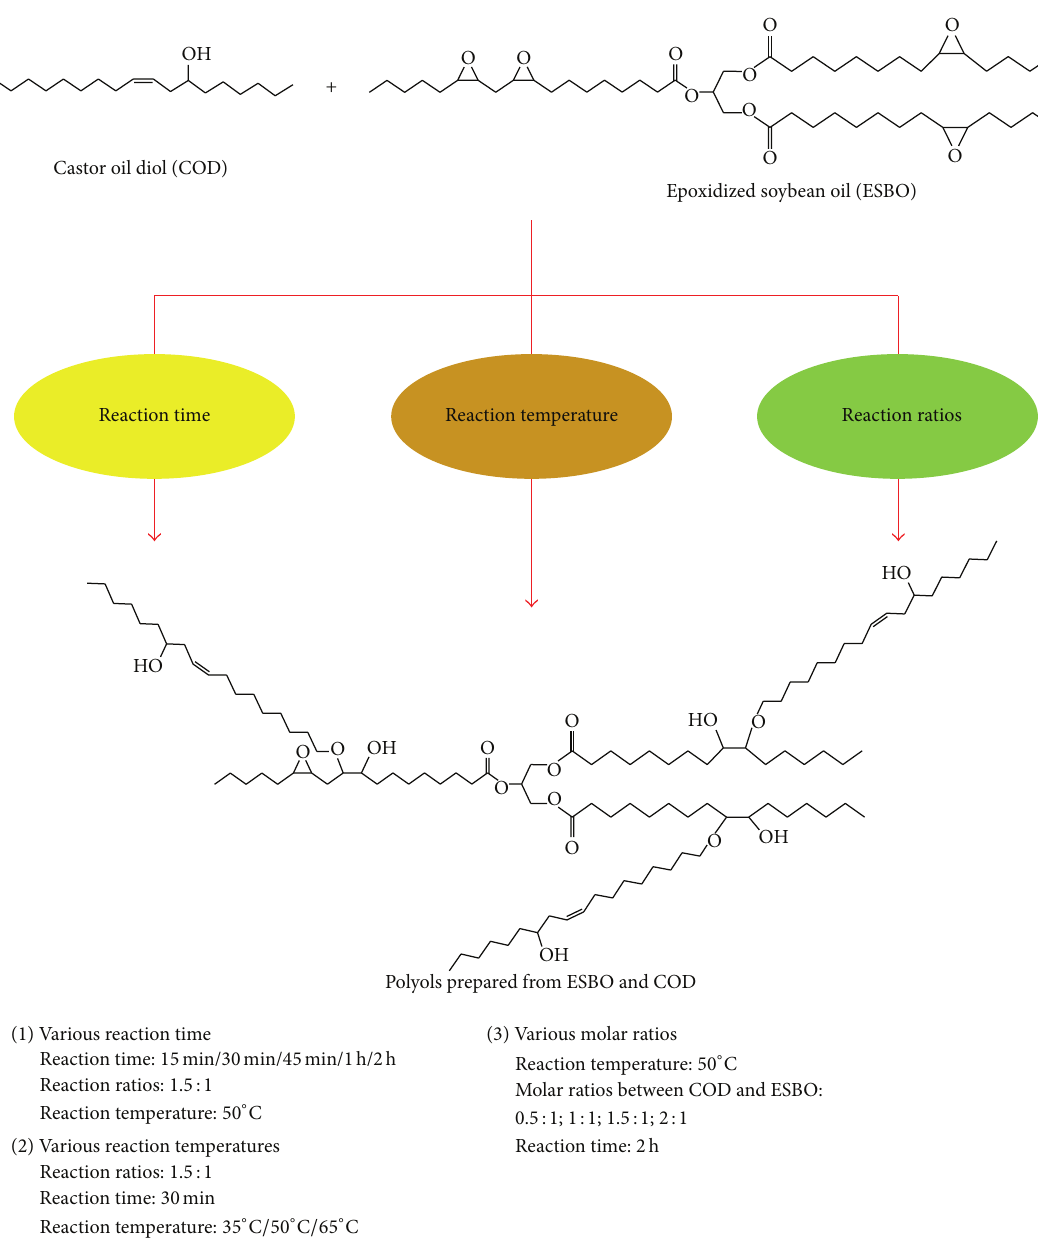
Figure 2: Schematic routine of the preparation of